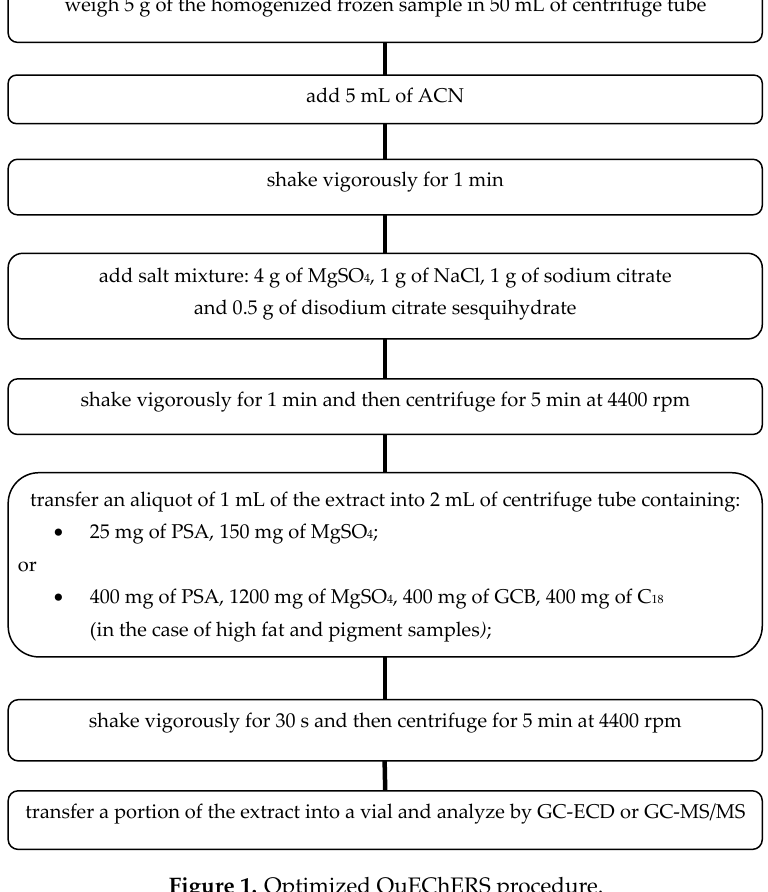
Figure 1. Optimized QuEChERS procedure.